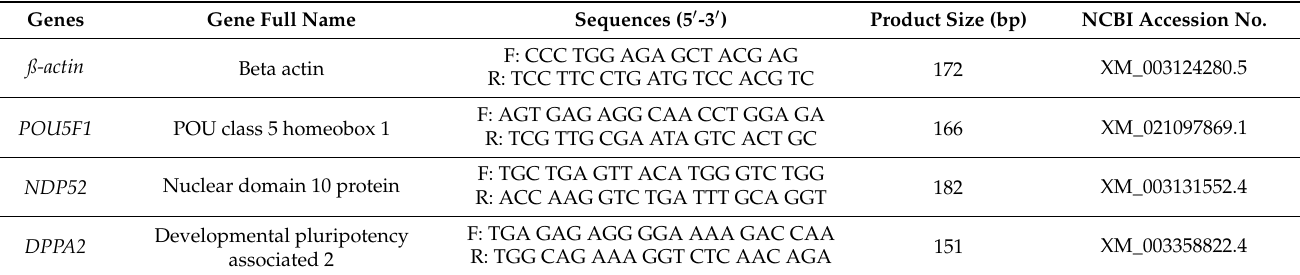
Table 1. S Specific primers used for gene expression analysis by